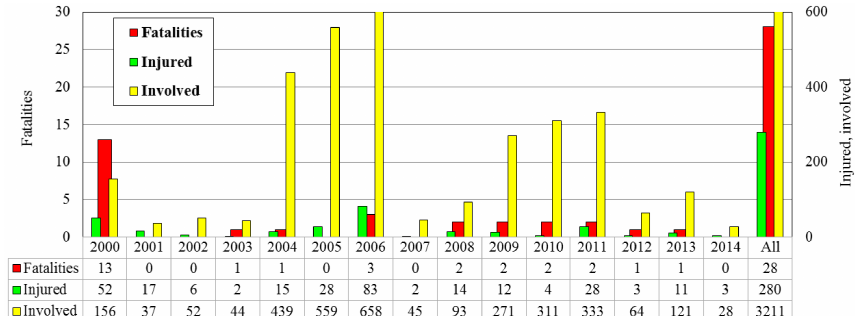
Figure 1. Number of fatalities, injures and involved people in the years of the study period.